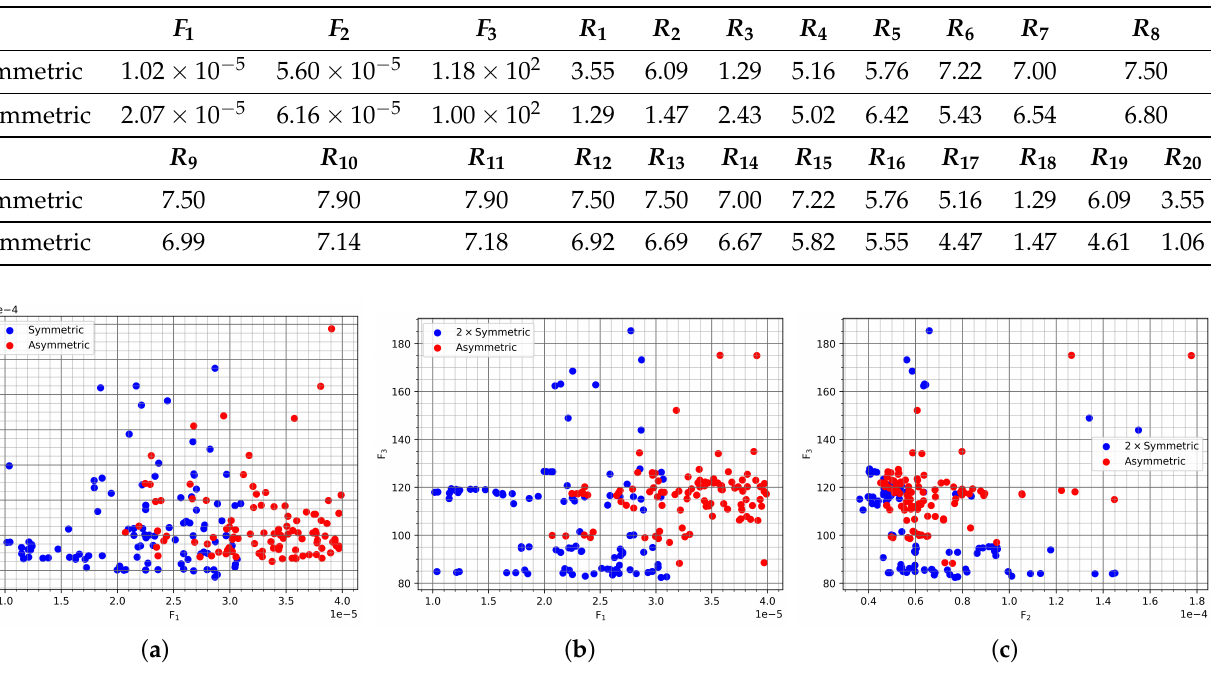
Table 4. Solutions based on the F 1 sorting in case (a).